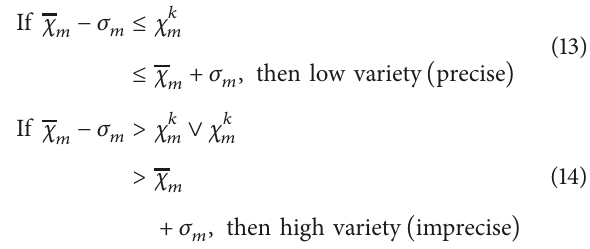
where 𝜒 𝑚 is predicted traffic flow for the link (m), 𝑥 𝑚 is observed traffic flow for the link (m), 𝑐 𝑙 is lower accurate 𝑚 limit for the link (m), and 𝑐 𝑢 is upper accurate limit for the 𝑚 link (m). The allowed accuracy and variability are presented in (11) and (12),